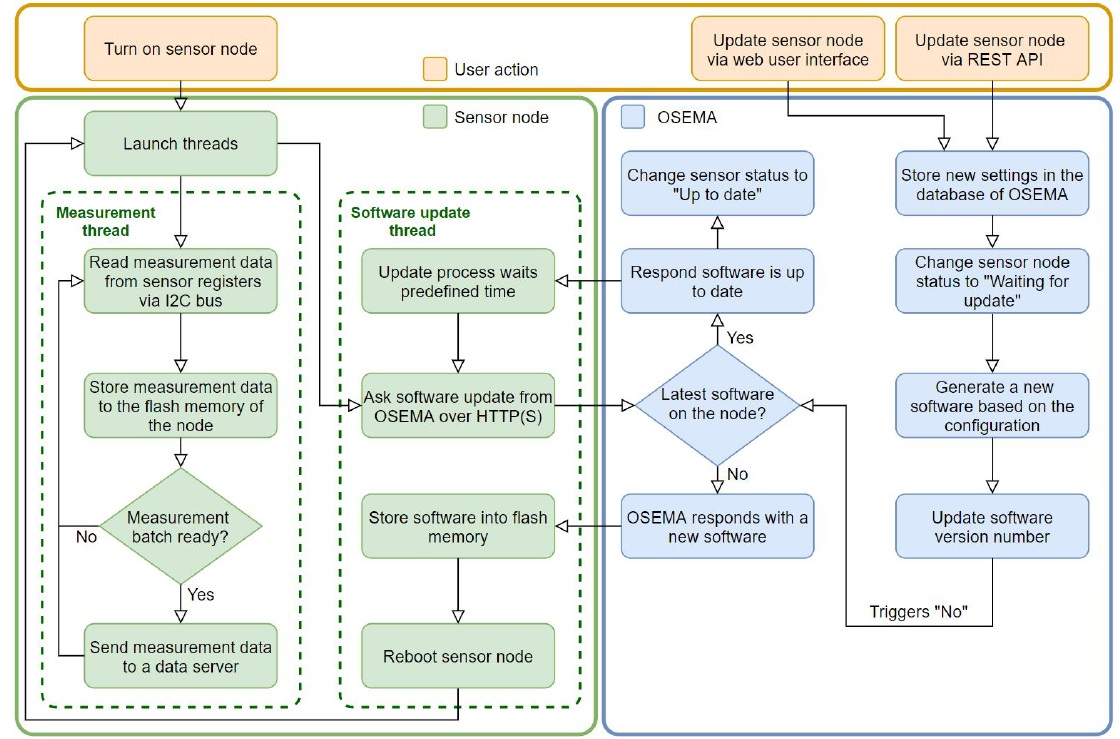
Figure 4. The operation of a sensor node and its interaction with